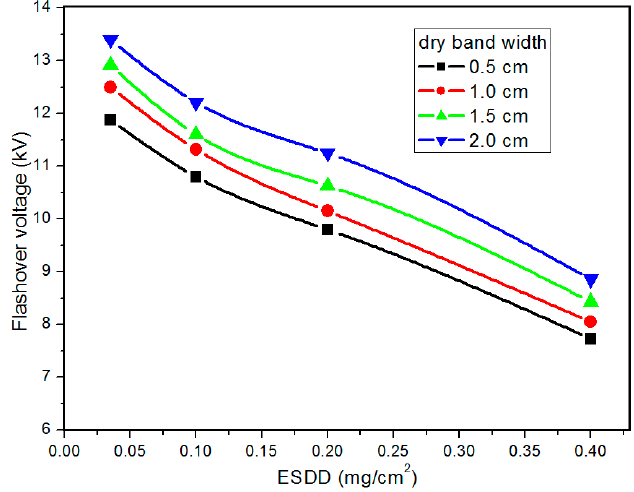
Figure 17. Flashover voltage at different dry band widths. where NSDD = 0.75 mg/cm 2 , humidity level = low, temperature = 10 °C, and standard deviation = 2.6%–5.1%.